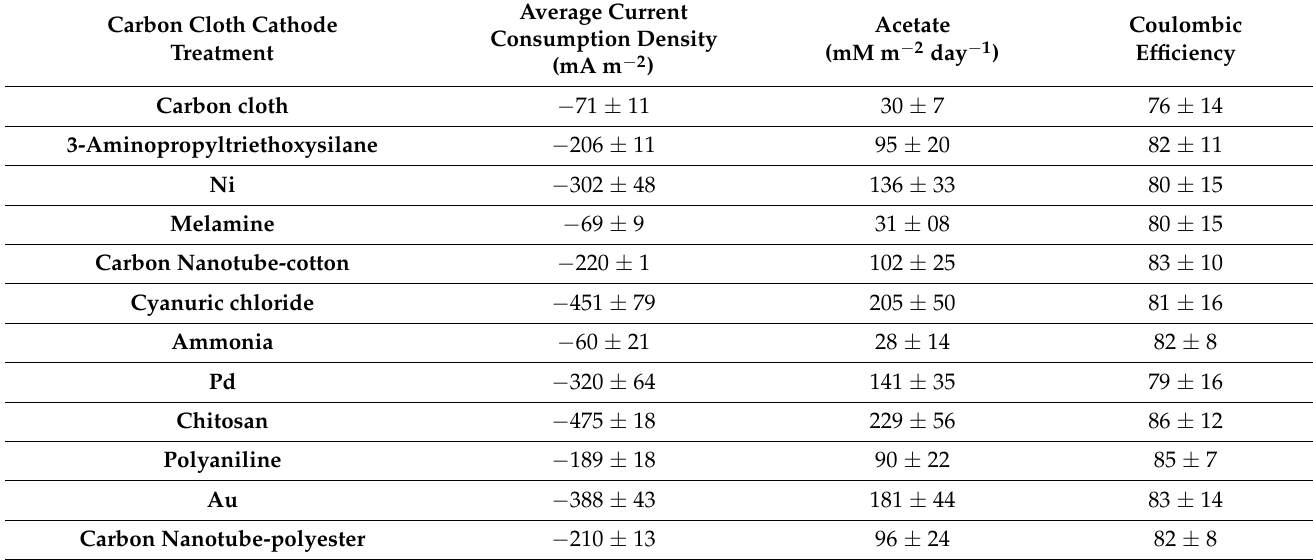
Table 2. It depicts the carbon cloth cathode treatment and acetate production rate for each day including consumption density